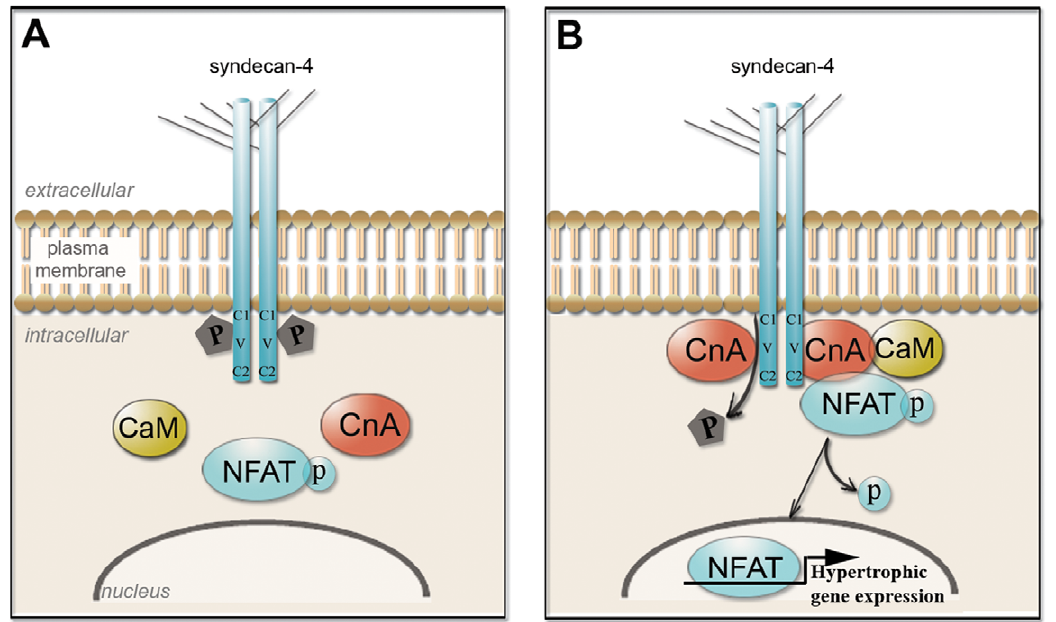
Figure 8. Schematic illustration of proposed syndecan-4-CnA interaction. Phosphorylation of S179 in syndecan-4 renders the CnA-NFAT pathway inactive (left box). Dephosphorylation of syndecan-4 induces binding of CnA and calmodulin (CaM) to syndecan-4 and subsequent activation of the NFAT transcription factor (right box).